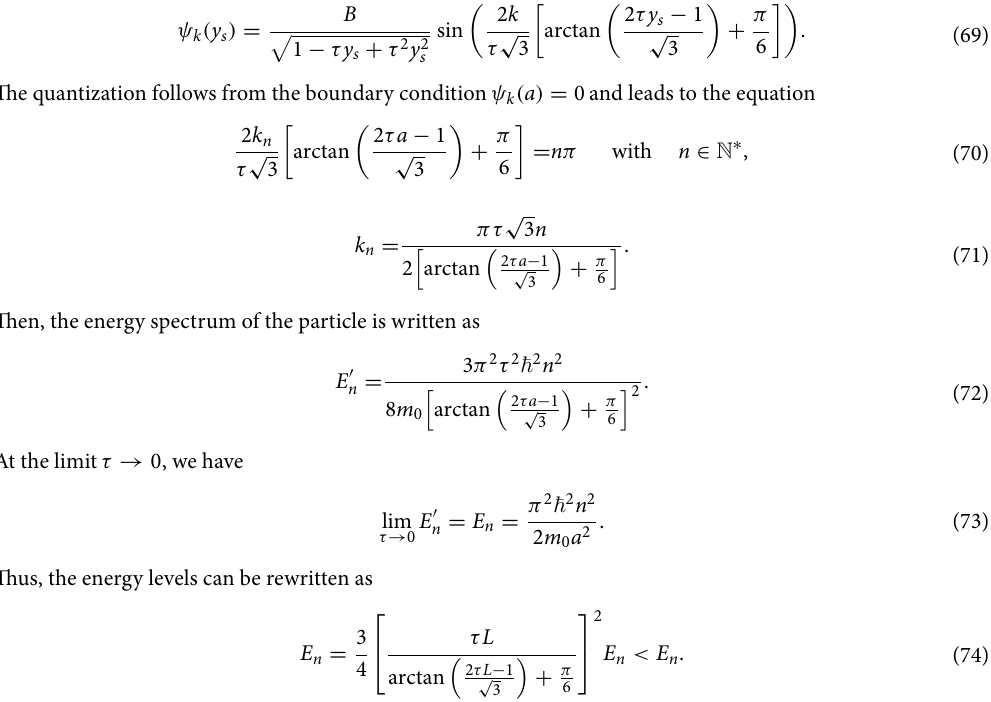
ψ k ψ k versus k ′ | � �